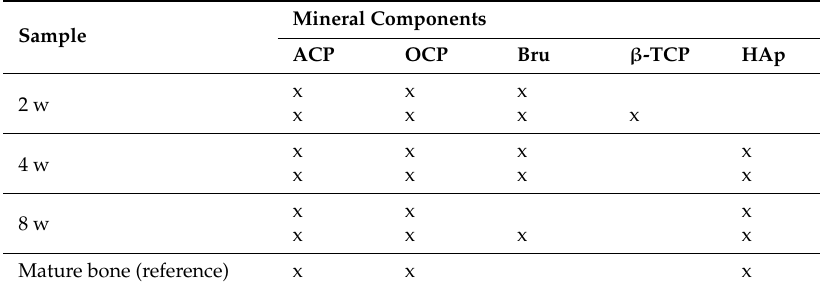
Table 2. The presence of calcium phosphate minerals in the samples under study at different healing stages (ACP = amorphous calcium phosphate; OCP = octacalcium phosphate; Bru = brushite; TCP = tricalcium phosphate; Hap =